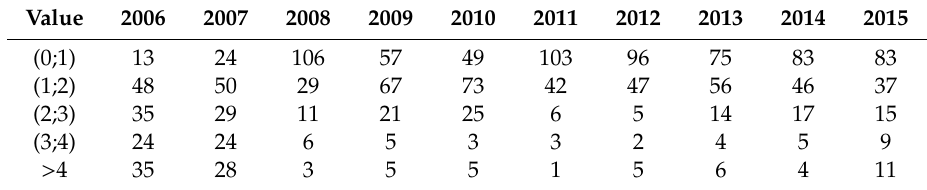
Table 3. Distribution of Tobin’s Q—number of companies and untransformed variables.